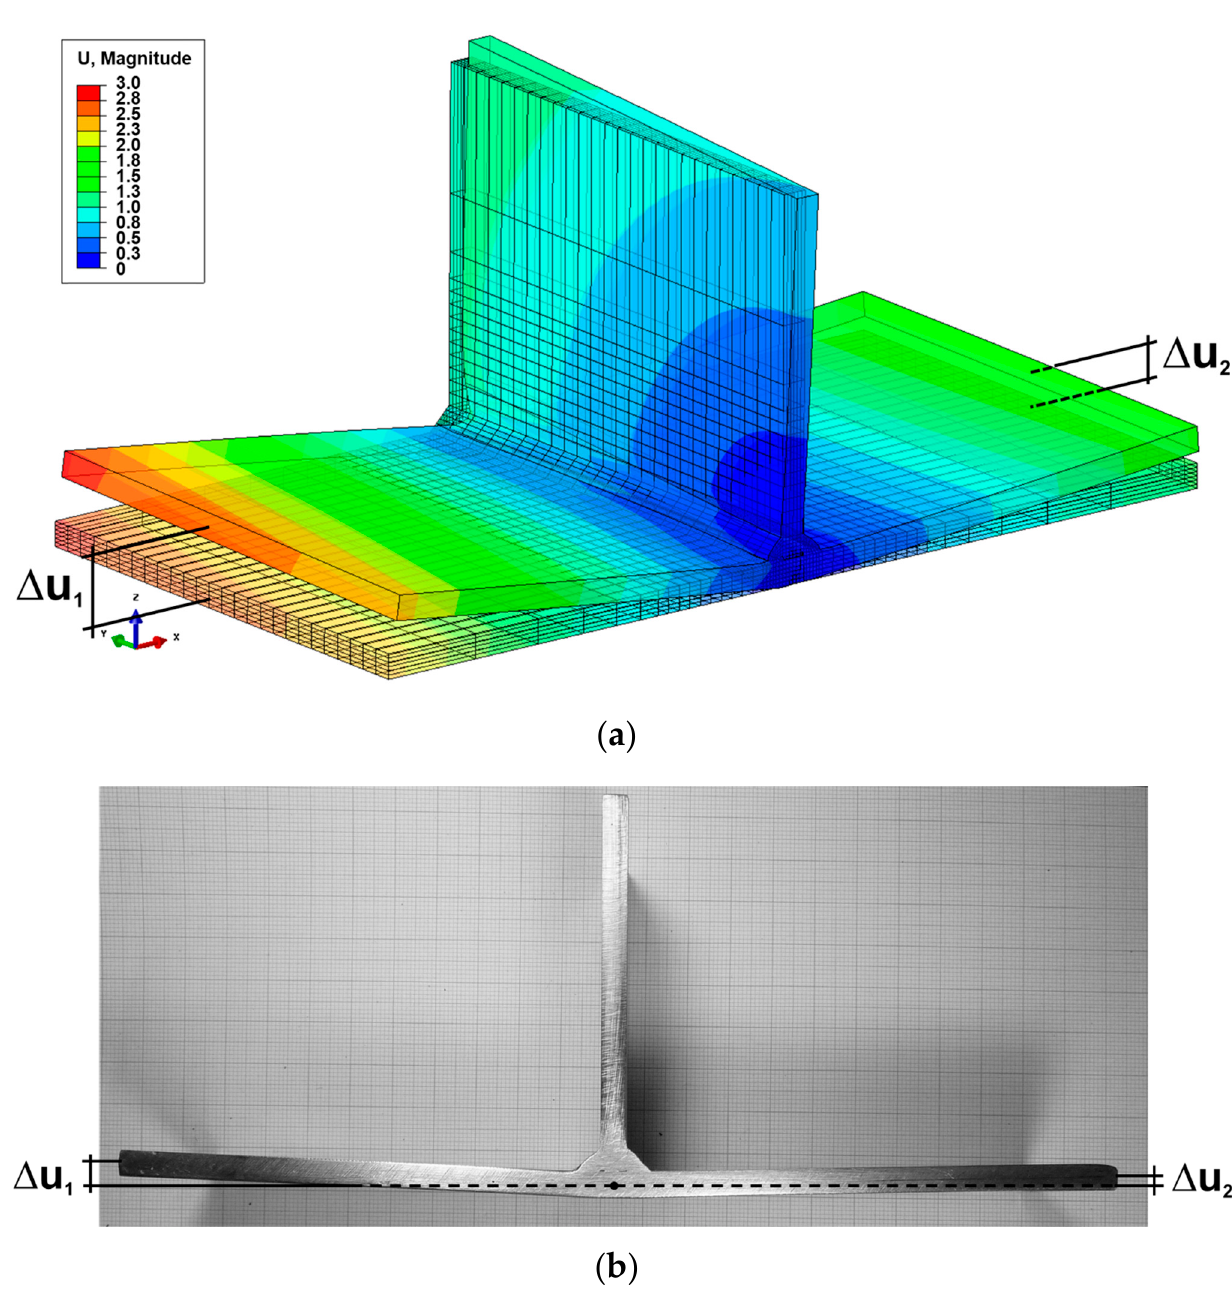
Table 2. Residual distortion comparison.